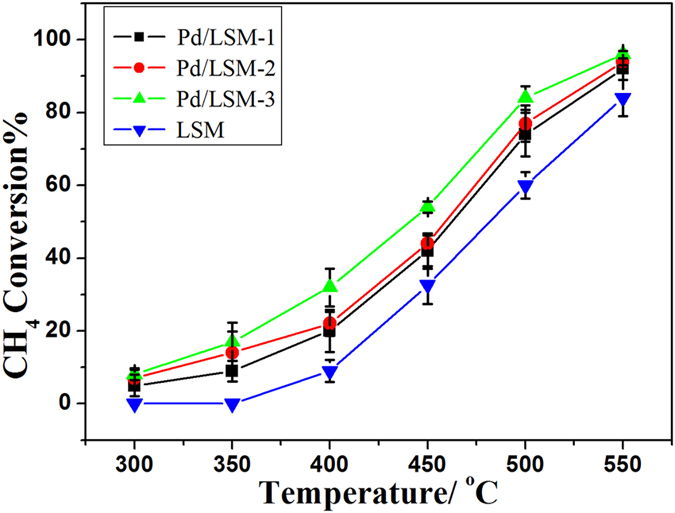
conversion of CH4 over LSM and Pd/LSM-x (X = 1, 2 and 3) catalysts.